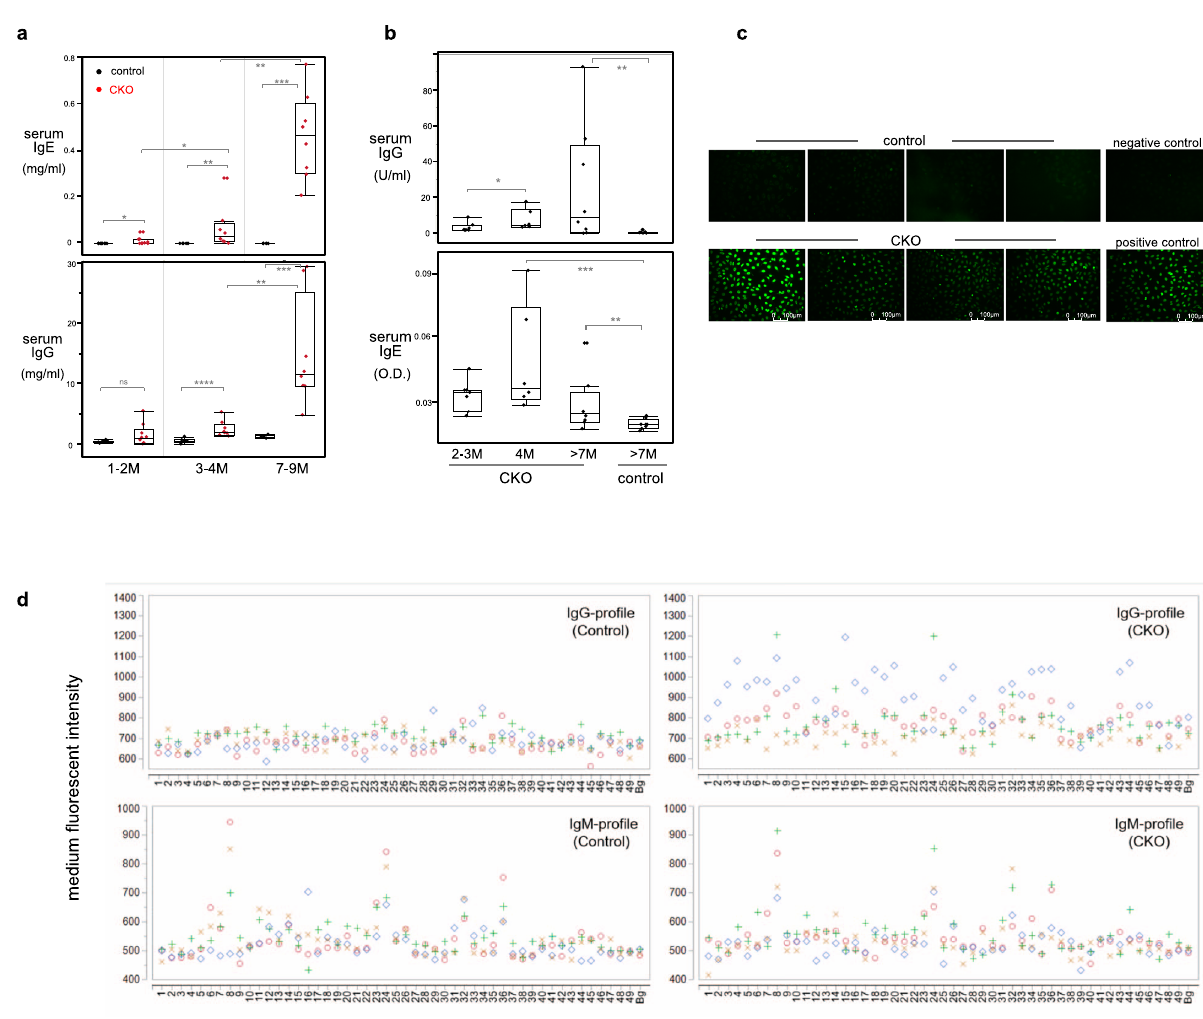
Fig. 4 CKO mouse serum contains autoantibodies to dsDNA, nuclear antigen, and glycan autoantigens. a IgG and IgE levels in serum of age-indicated control or CKO mice were measured by Elisa, n = 6 – 8 mice per mouse group, * p < 0.03, ** p < 0.001, *** p < 0.006, **** p < 0.002, ns, not signi fi cant ( p < 0.2), nonparametric Wilcoxon one-way test. b Anti-dsDNA IgG and IgE levels in serum of age-indicated CKO and control mice were measured by Elisa, n = 5 – 8 mice per mouse group, * p < 0.05, ** p < 0.03, *** p < 0.02, nonparametric Wilcoxon one-way test. c Anti-nuclear antigen (ANA) autoantibody in serum of CKO or control mice (7 – 14 months old) was tested, n = 8 mice per mouse group. Representative data for four mice from each group are shown. None (0/8) of the control mice and 5/8 of CKO mice show positive for ANA. d Anti-glycan IgG and IgM autoantibodies in serum of control or CKO mice were measured by carbohydrate microarray assay. Overlay plots of anti-glycan autoantibody IgG (upper) and IgM (lower) pro fi les of serum from four control or CKO mice (>7-month-old) are shown. Each symbol represents data of IgG or IgM reacting to an individual glycan antigen for an individual mouse serum. y -axis: the mean values of triplicate microspot detections of individual sera sample for each antigen, x -axis: corresponding ID of glycan antigens. Oligo-mannoses (#8 – 34), asialo- and aglacto-glycans(#3 – 6), O -glycan core-based autoantigens (#43 – 44), Man1Gn2Asn (#8), Man9Gn2Asn (#24), Glc1Man9 (#32), GlcNAc-RB (#36). Information of each glycan antigen is shown in Supplementary Table 6. The mean values of background microspots (Bg) of each staining are shown in the rightmost of X axis in each graph. Box plots in a , b : box draws 75% (upper), 50% (center line), and 25% (down) quartile, the maxima and minima outliers are shown as top and bottom line,